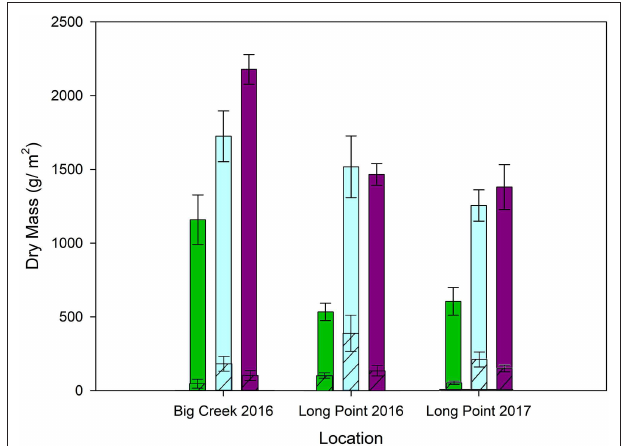
FIGURE 3 | Stacked bar graph indicating annual production as total live biomass, partitioned into aboveground (solid bars) and belowground (stripped bars) components. Bars contrast meadow marsh (green), cattail (blue) and P. australis -invaded plant communities (purple) in a higher nutrient (Big Creek NWA 2016) and lower nutrient (Long Point Provincial Park 2016) environment. Bars from Long Point Provincial Park 2017 average across a water depth gradient (14–56cm water depth). Standard error bars shown. Note that belowground biomass is one growing season’s production within the upper 11.3cm of